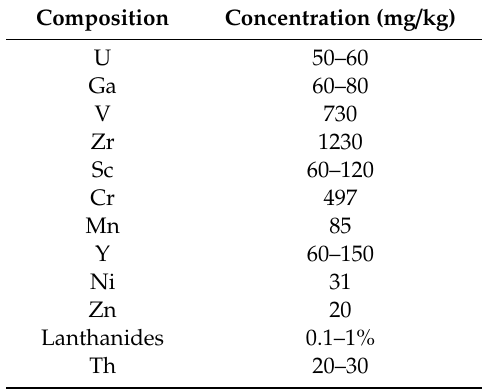
Table 3. Typical concentrations of trace, rare-earth and radioactive elements in RM